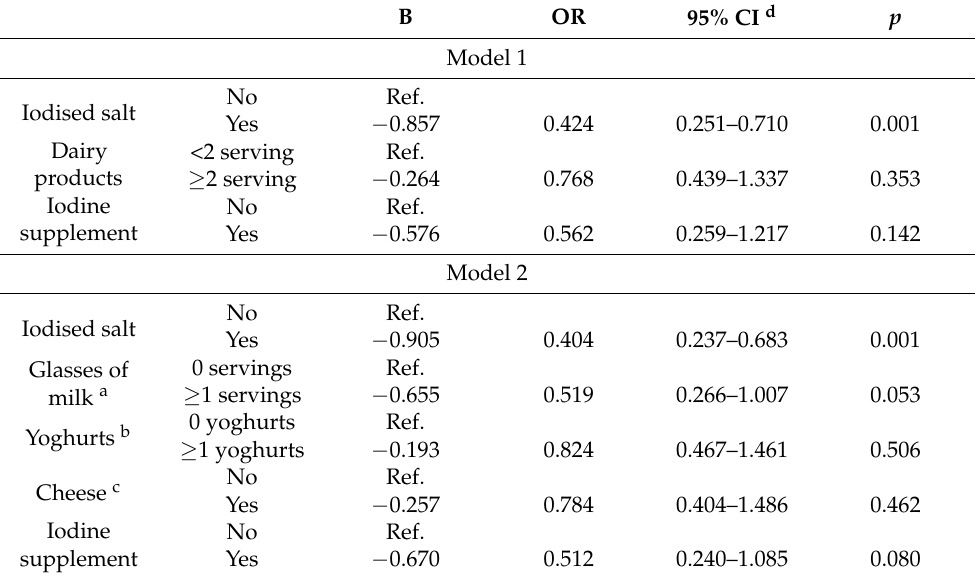
Table 2. Multivariate binary logistic regression analysis to determine the effect of the ingestion